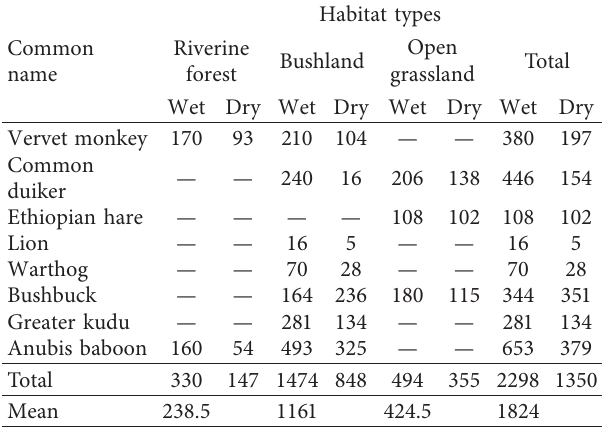
Table 2: Mammalian species in the three habitats during dry and wet seasons.